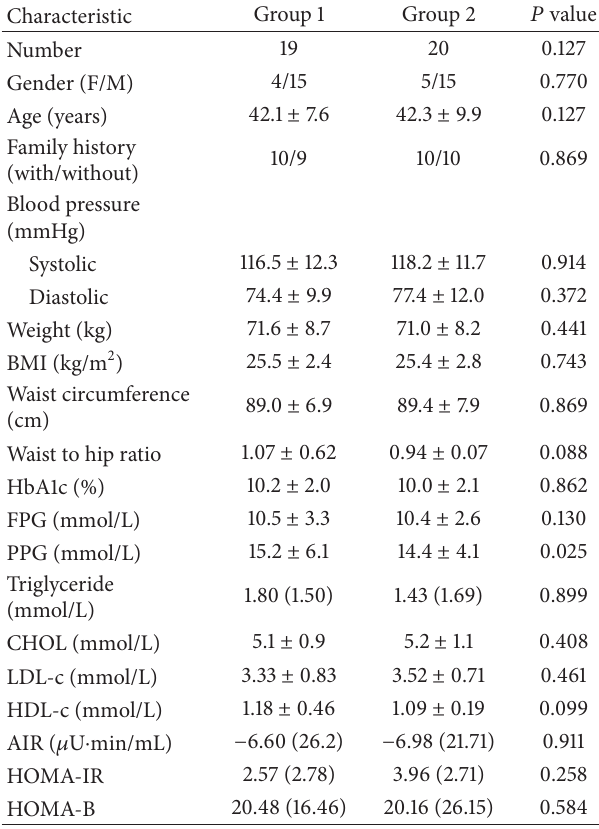
except for PPG, which was slightly higher in CSII + Lira group ( 15.2 ± 6.1 mmol/L versus 14.4 ± 4.1 mmol/L, 𝑃 = 0.025 ).